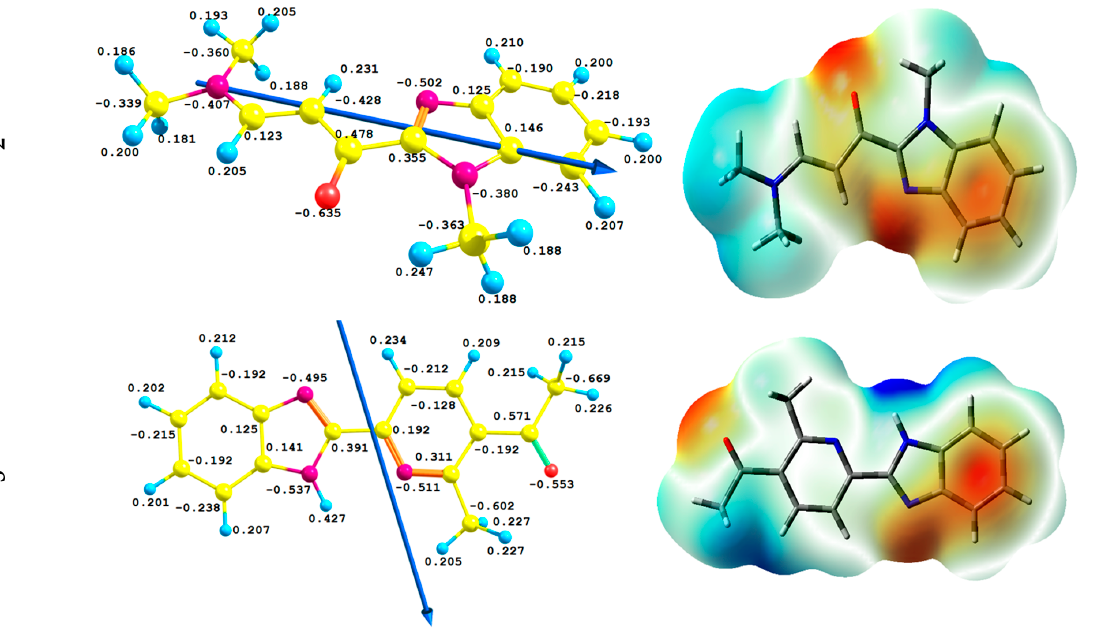
Figure 8. The natural charges over the optimized structure with dipole moment vector ( left ) and molecular electrostatic potential (MEP) map ( right ).